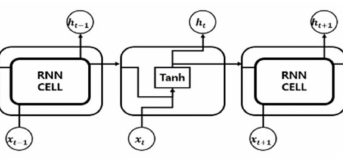
Figure 6. Typical recurrent neural network structure.